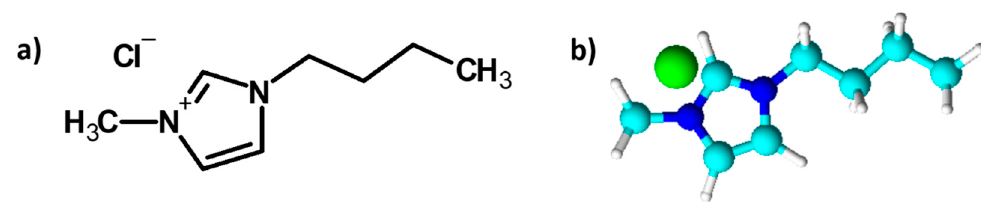
Figure 1. ( a ) Chemical representation of the OSDA 1-butyl-3-methylimidazolium chloride and its ( b ) 3D representation obtained using the freeware programs ChemSketch (ACD/Labs 2017.2.1, copyright 1994–2018) and ACD/3D Viewer (ACD/Labs 2017.2.1, copyright 1997–2017).